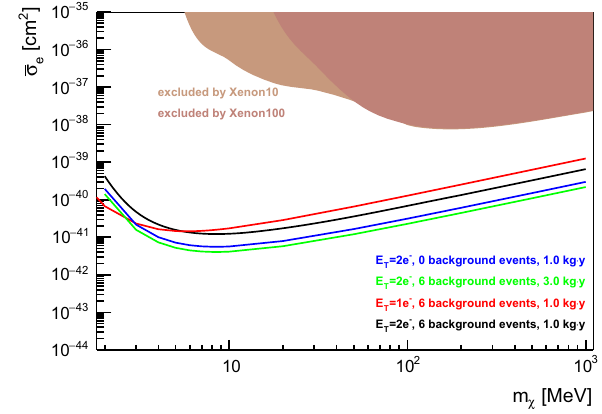
Fig. 11 Expectedsensitivityfordarkmatter-electronscatteringassum- ing a threshold of Q = 2 e − , six background events and an exposure of 1 kg year (black line). In addition we show the sensitivity with an increasedthresholdof Q = 3 e − (blue),reducedexposureof0.1 kgyear (green) and increased background of ten events (red). We assume a con- stant form factor of F DM ( q ) = 1. For comparison the best limit using data from Xenon10 and Xenon100 is shown [27]